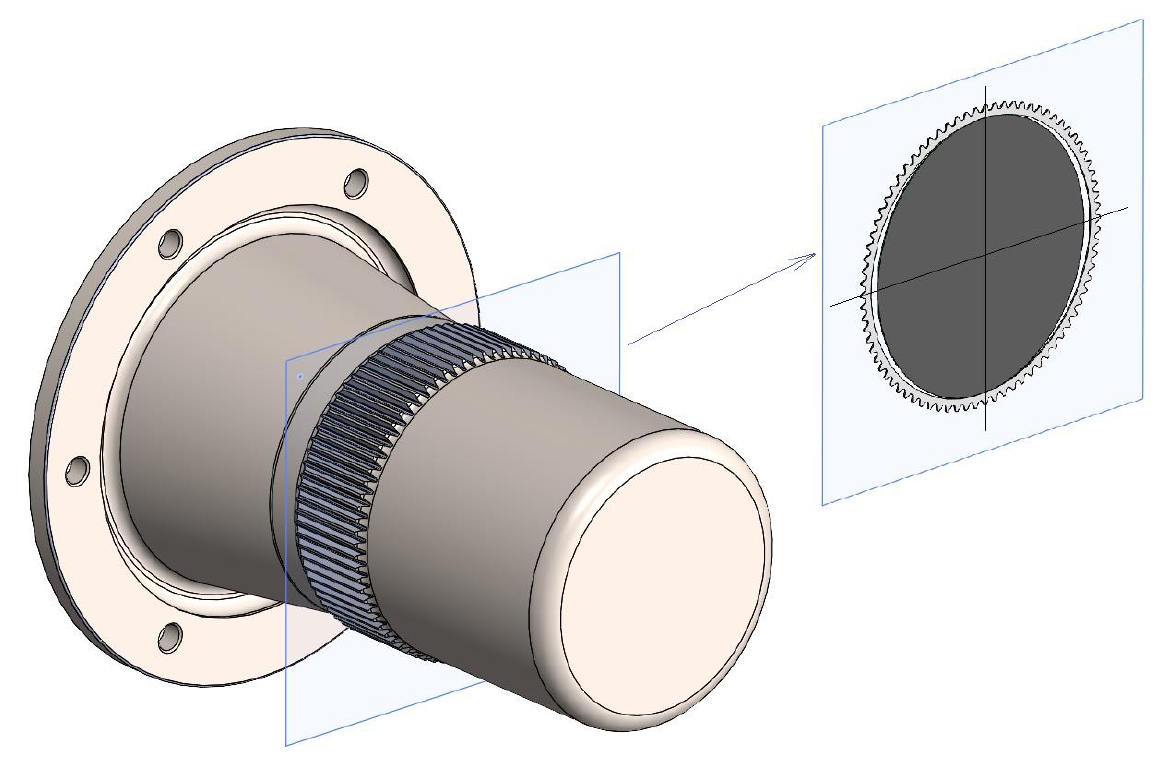
Figure 7. Essence of creating a two-dimensional model as a cross-section for calculation.